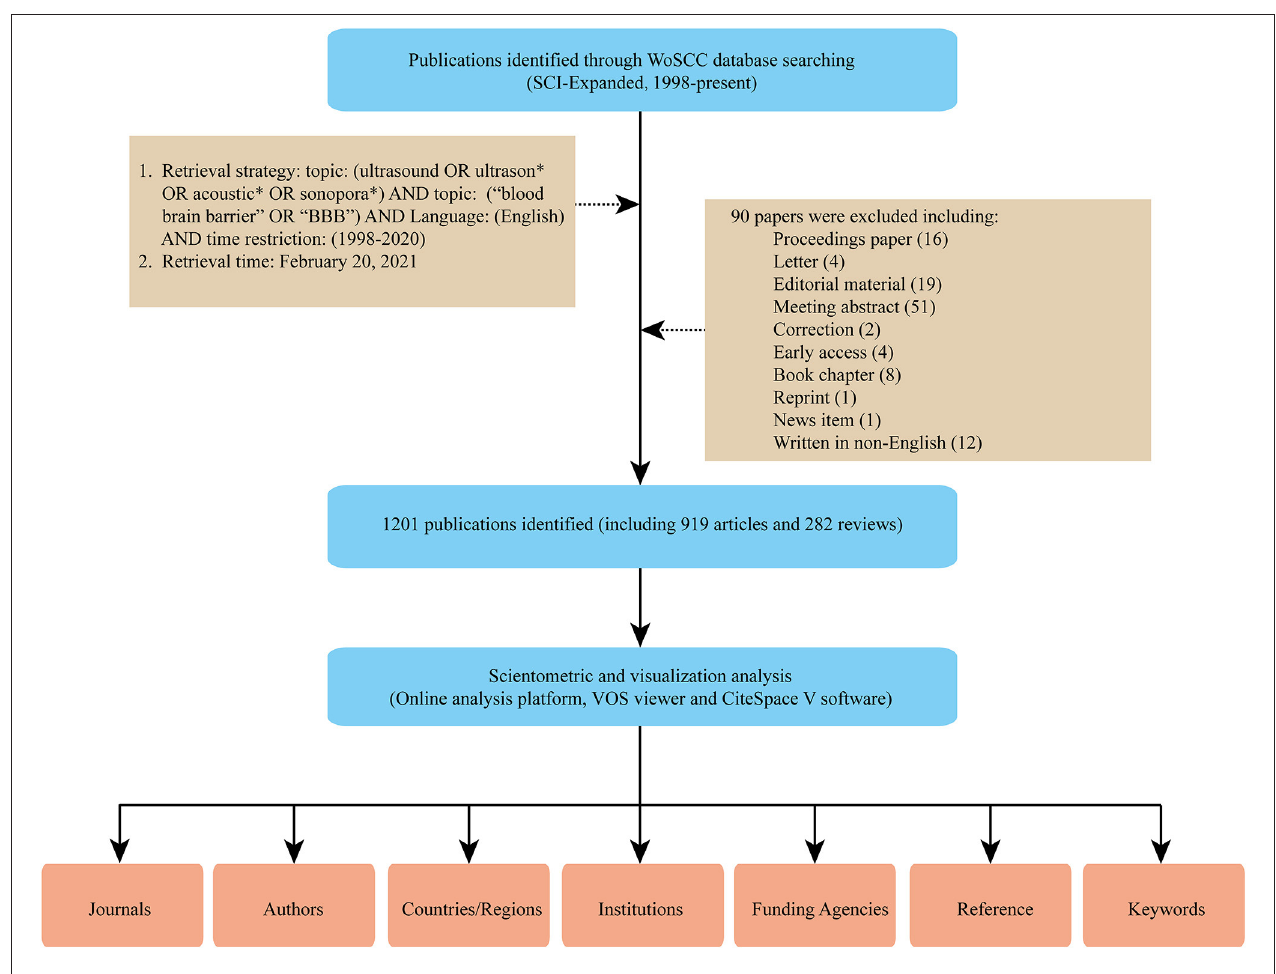
FIGURE 1 | Flow diagram of literature search, screening, and